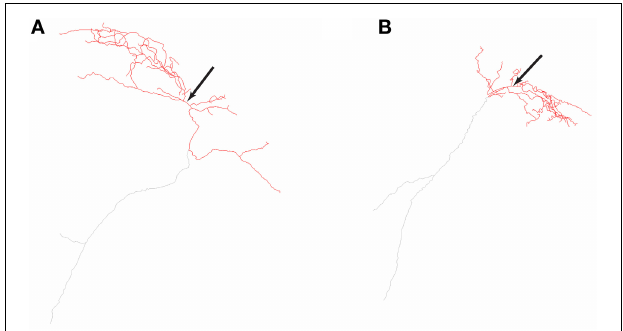
FIGURE 1 | Neurolucida reconstructions of the two O-LM cell morphologies used in this work. Two-dimensional representations of O-LM cell morphological reconstructions originally obtained in Lawrence et al. (2006a) and used in this work for models R3, R4, referred to as morphology 1 (A) and S3, S4, referred to as morphology 2 (B) . Arrows denote location of cell somata. Dendrites are denoted in red, and truncated axons shown in